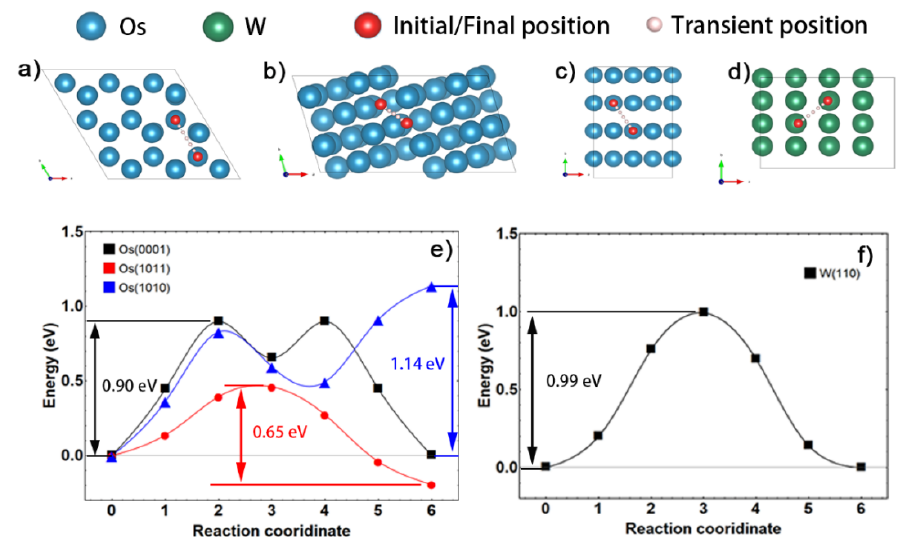
Figure 8. Models of surface atom migration of ( a – c ) Os on Os(0001)/(1010)/(1011) and ( d ) W on W(110), energy barriers of ( e ) Os on Os surface, ( f ) W on W(110).